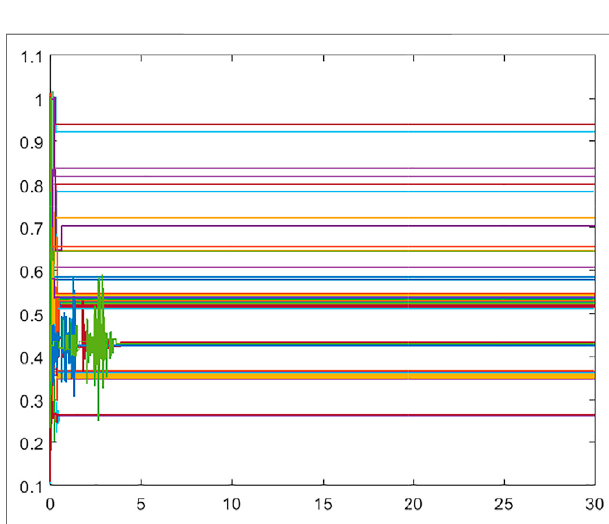
FIGURE12| DynamicweightsusingtheproposedmethodforIEEE-118 bus system.